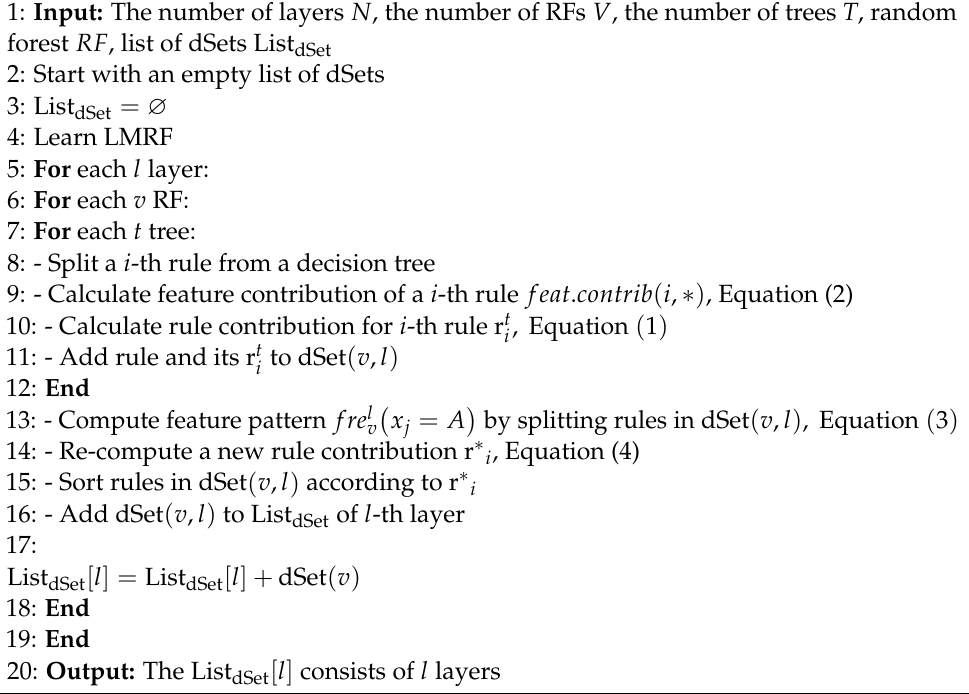
Algorithm 1: Rule elimination based on feature contribution and feature